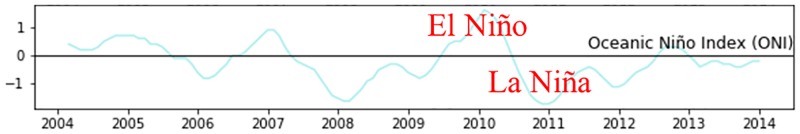
The ONI signature in 2004–2013.